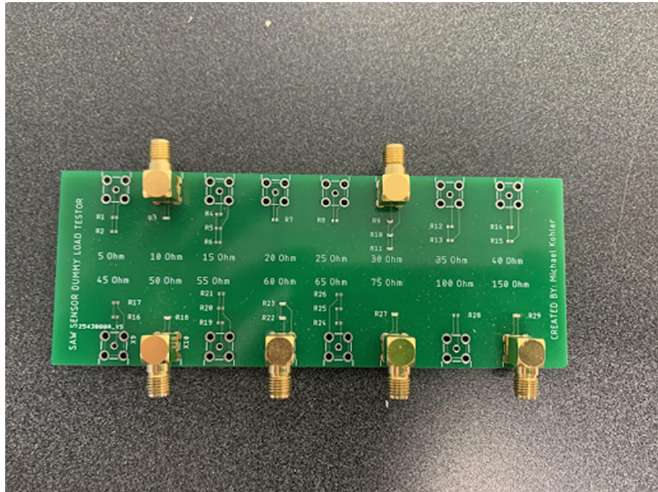
Figure 9. Variable load board.